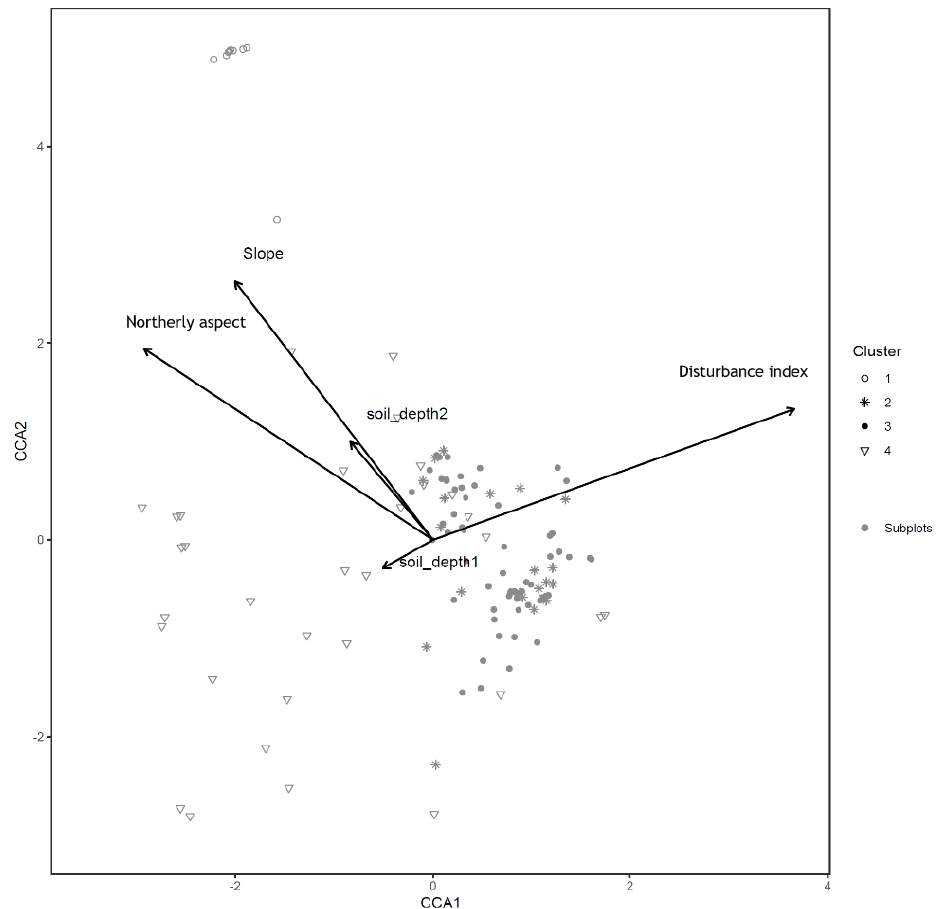
Figure B2. Canonical correspondence analysis of 140 subplots across six sacred forests for understory saplings and shrubs. Subplots are labeled according to the four clusters produced by the cluster analysis (1: Fagus sylvatica ; 2: Carpinus orientalis / Acer monspessulanum ; 3: no significant species; 4: Carpinus betulus / Ostrya carpinifolia ). Arrows indicate explanatory variables with their arrowheads indicating direction of